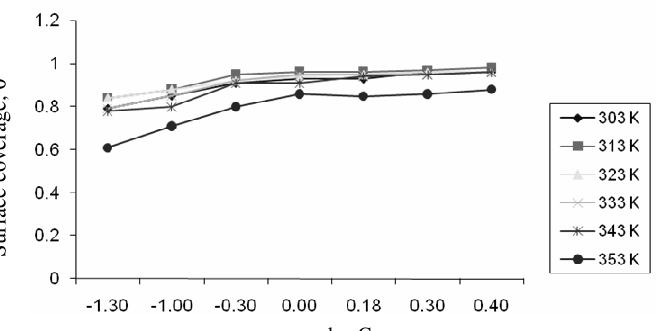
Figure 4. Langmuir adsorption isotherm of MNP extract on mild steel in 1 N HCl at various temperature